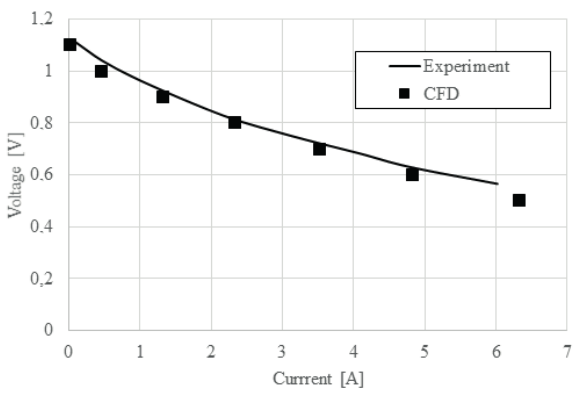
Figure 7: Voltage [V] vs. current [A] curve for the single